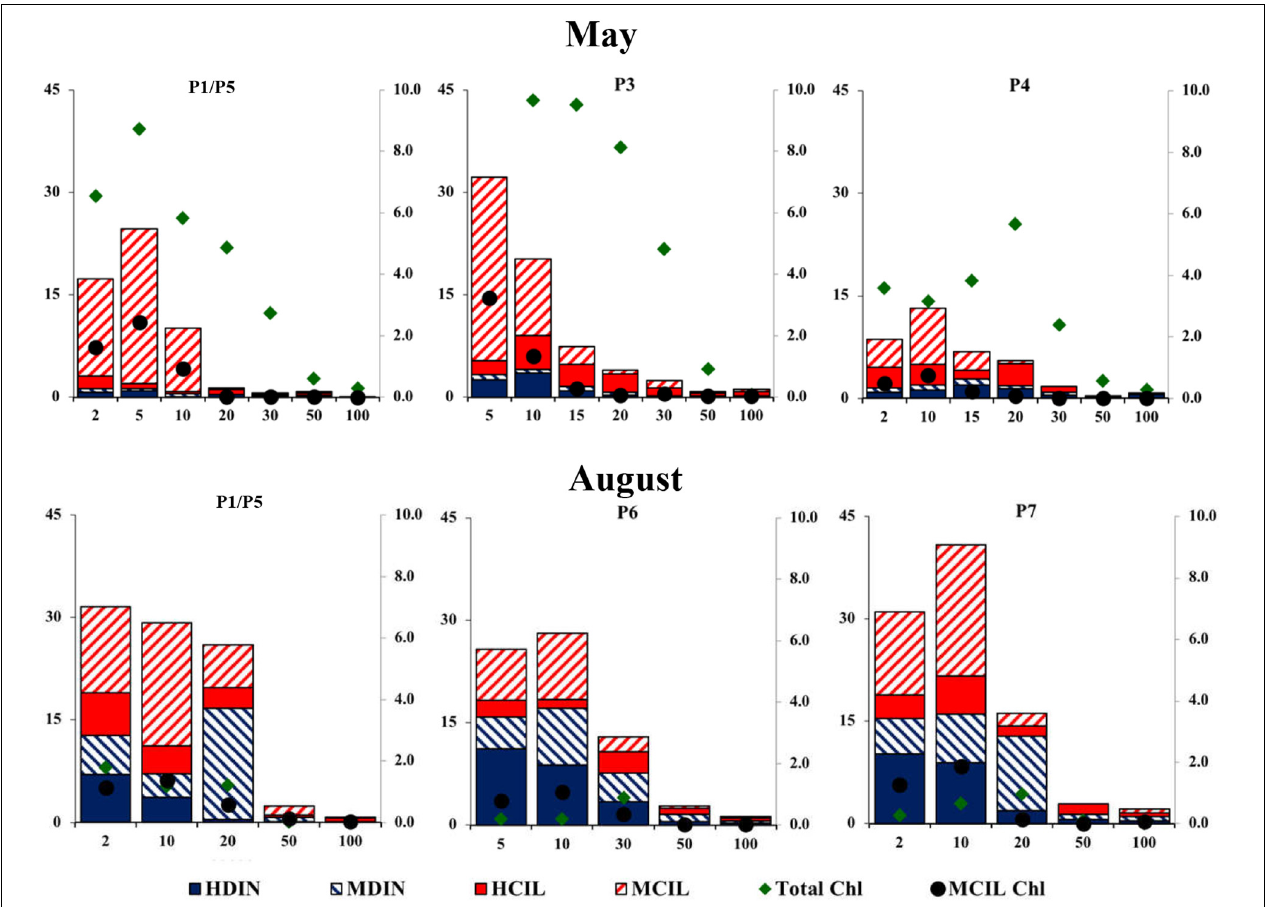
FIGURE 4 | The distribution of chlorophyll, mixotrophic ciliate chlorophyll, and biomass of different microzooplankton at the process stations in May and August 2014. Microzooplankton group abbreviations are as in Figure 2 . Total Chl = the concentration of extracted chlorophyll; MCIL Chlx10 = calculated mixotrophic ciliate chlorophyll multiplied by